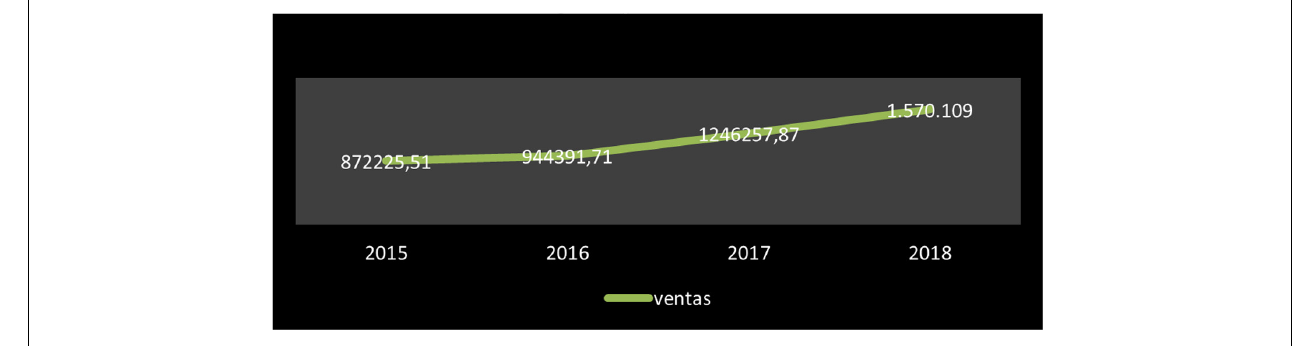
FIGURE 2 | Sales development (Sales value in EUR). TABLE 8 | Economic resources: Commercial Registry. Consulting